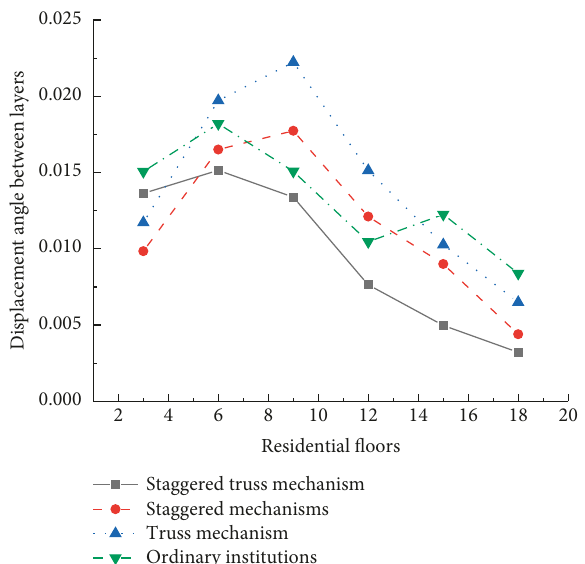
Figure 5: Interstory displacement angles of different floors under large